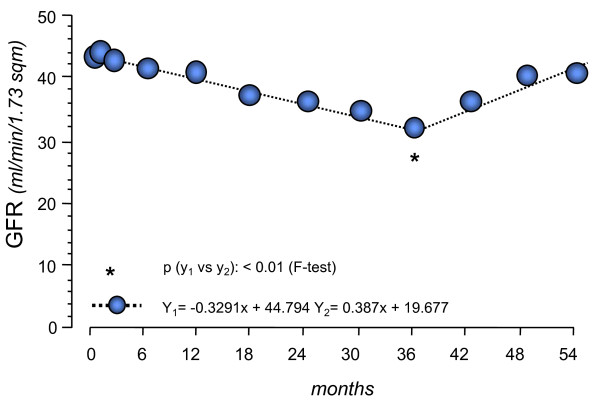
GFR time-dependent changes over time in the 26 patients on prolonged ramipril therapy in the Ramipril Efficacy in Nephropathy (REIN) study. The breakpoint analysis found that GFR time-dependent changes could not be described by one single first-degree equation, but rather by two different equations describing randomization to 36 months and from 36 to 54 months, respectively. Y1 and Y2 equations describe the interpolating curves before and after the breakpoint, respectively.